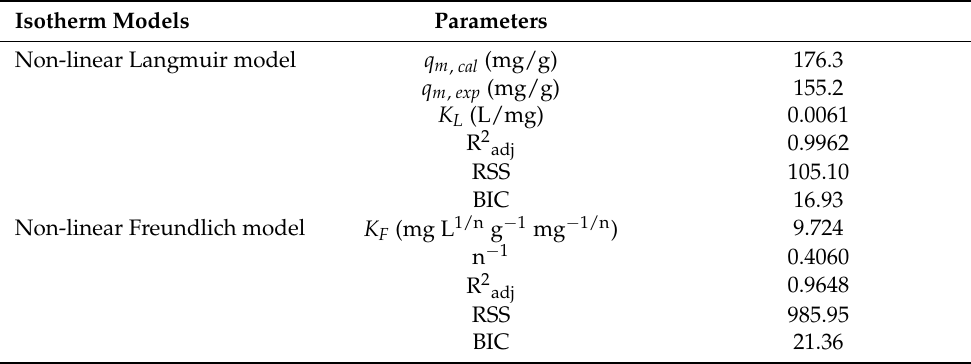
Table 3. Non-linear adsorption parameters of PS-DMTD for Pd (II).